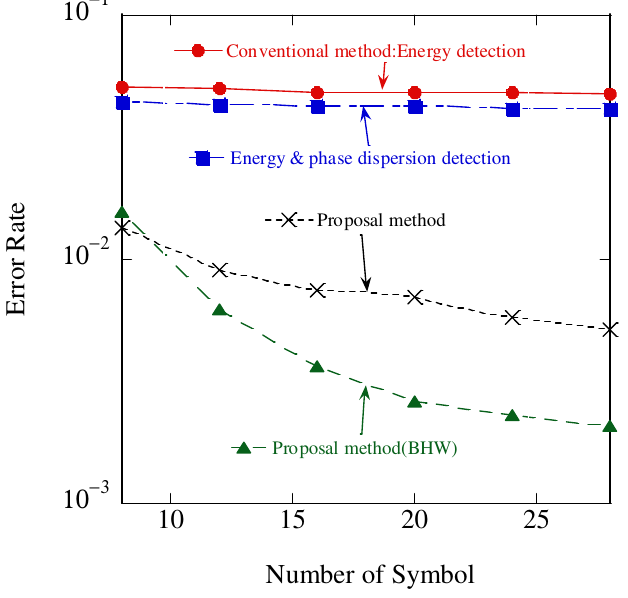
Figure 14. Aggregate accuracy